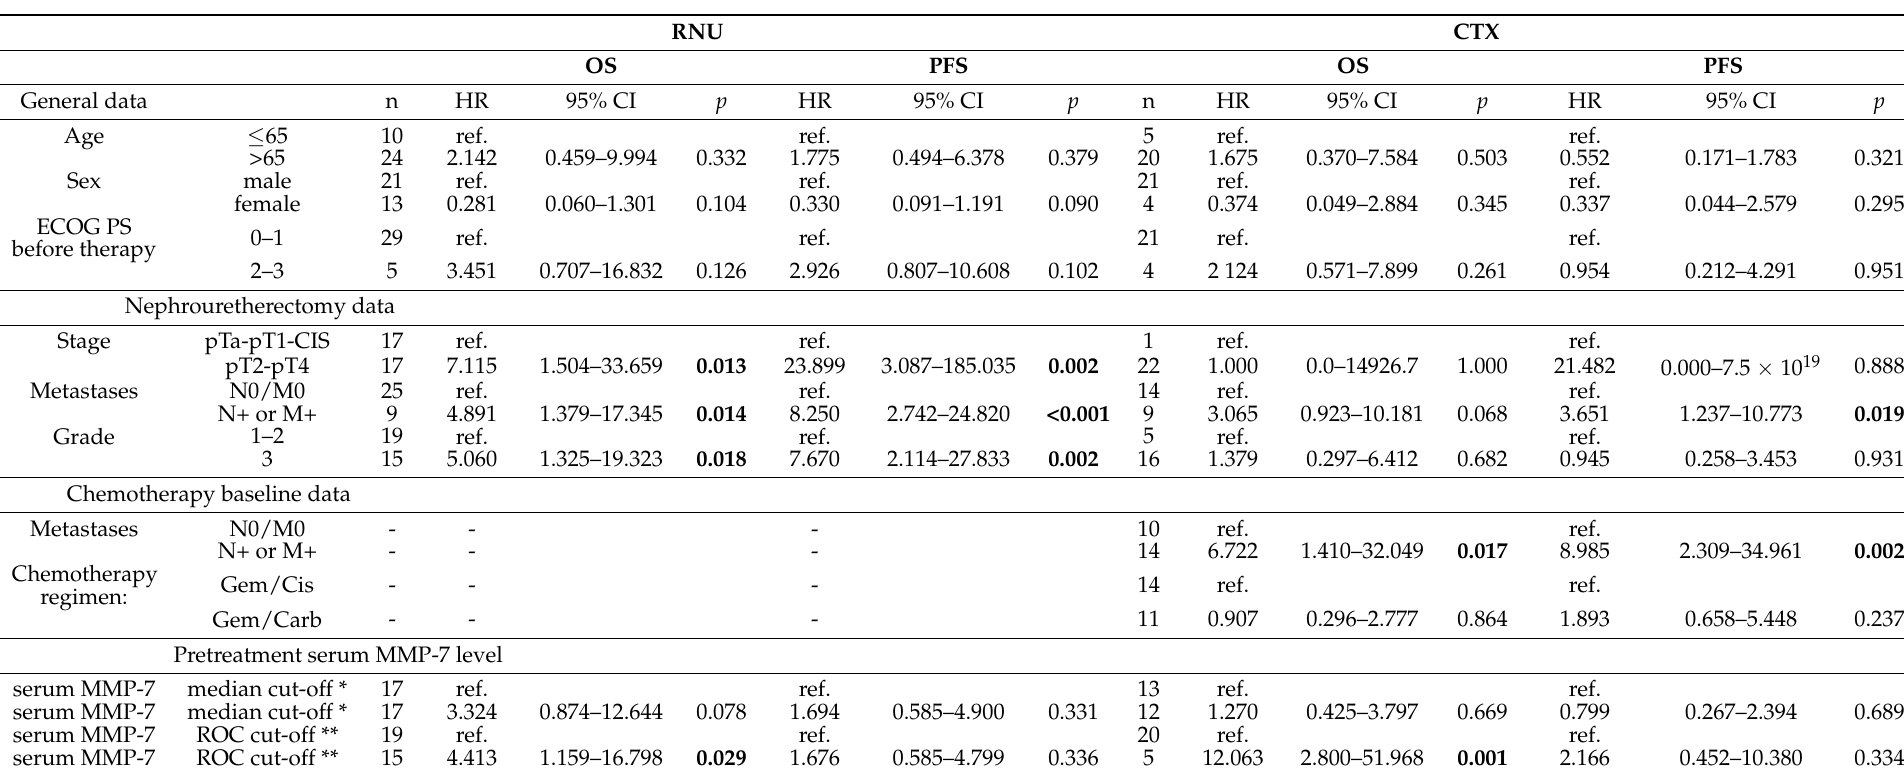
Table 3. Correlation of clinicopathological parameters and preoperative MMP-7 concentrations with patients’ prognosis; * median cut-off for RNU is 10.6 ng/mL, median cut-off for CTX is 8.8 ng/mL; ** ROC cut-off for RNU is 14.2 ng/mL, ROC cut-off for CTX is 17.9 ng/mL; RNU—radical nephroureterectomy, CTX- chemotherapy; OS—overall survival; PFS—progression-free survival; PS—performance status; Gem/Cis—gemcitabine + cisplatin; Gem/Carb—gemcitabine + carboplatin; bold font represents significant